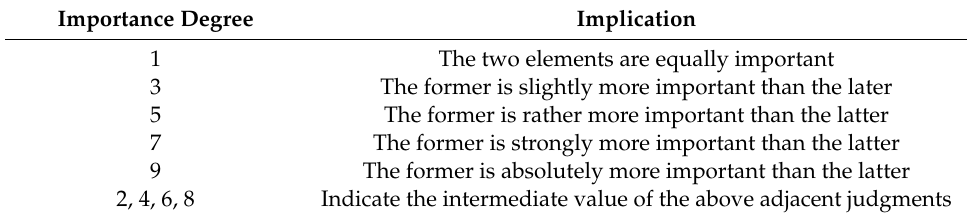
Table 2. Importance degree and implication for elements in i -AHP